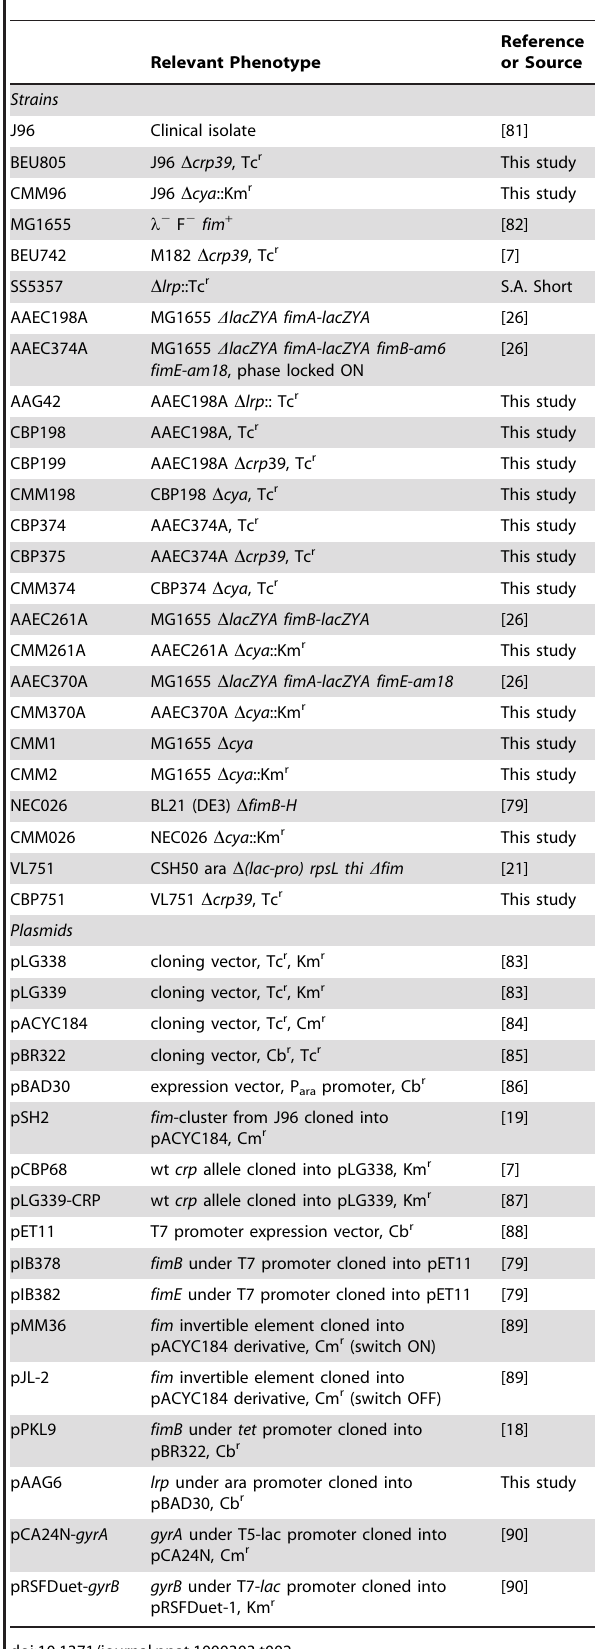
Table 2. Strains and plasmids used in this